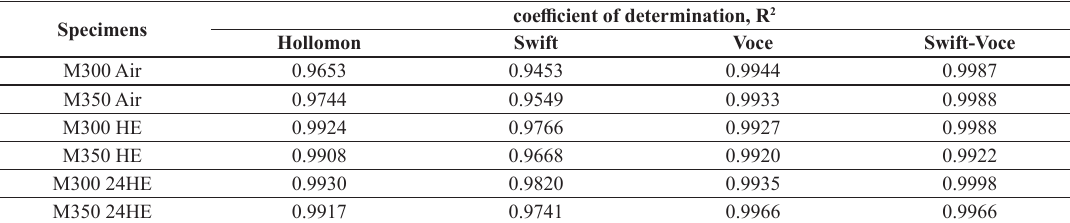
Table 5. Coefficient of determination values for Hollomon, Swift, Voce and Swift-Voce coupled model after fitting curves.